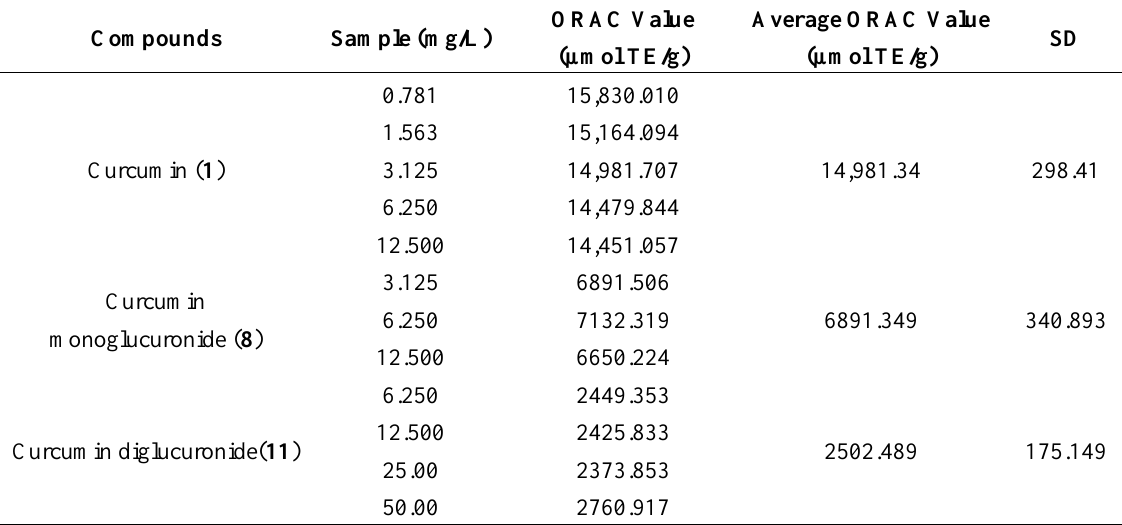
Table 2. Results of ORAC